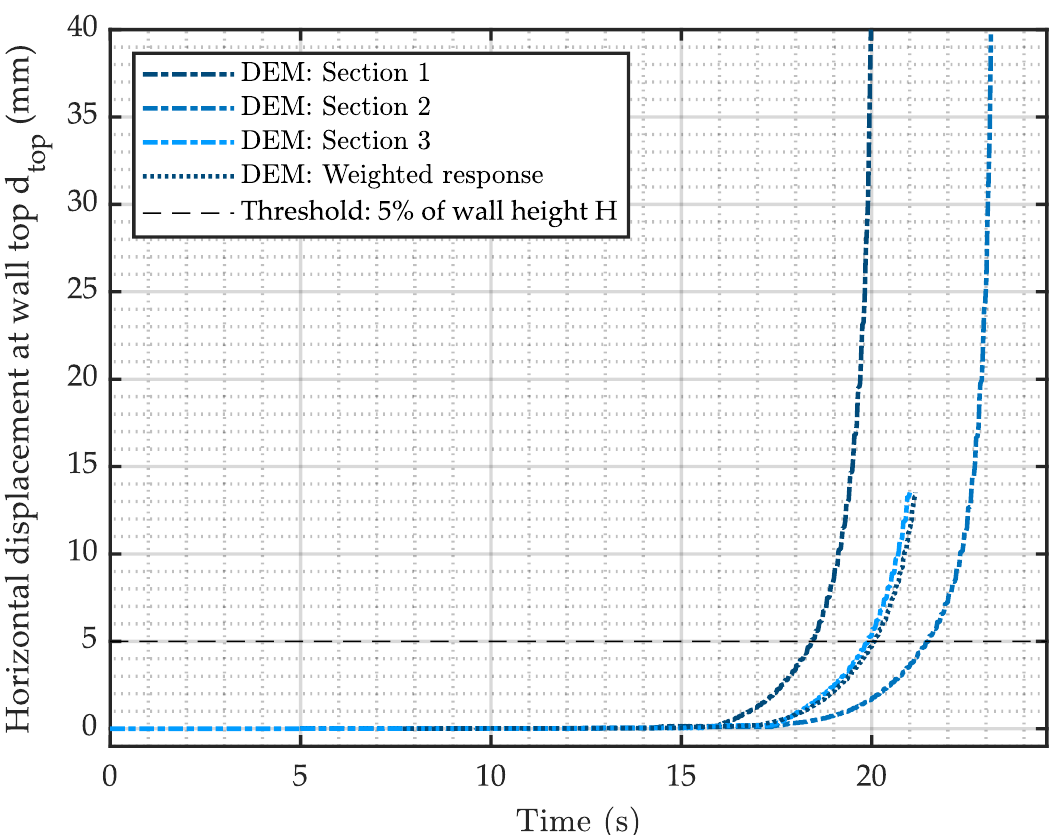
Figure 4. Comparison of the displacement at the top of the wall (slenderness H/B = 2.7) for the different cross-sections (Figure 3) and the global weighted response. Table 2. Computation of the weighted response illustrated with the threshold d top equal to 5 mm. Section